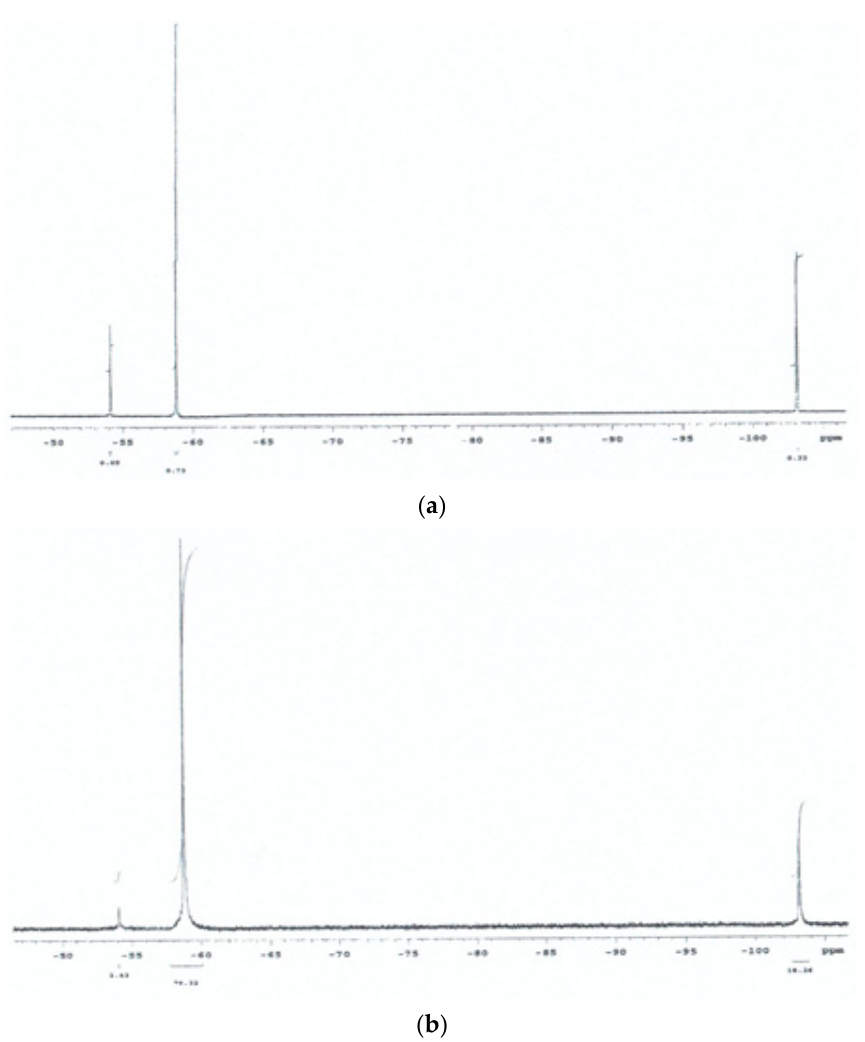
Figure 2. 19 F-NMR spectra of ( a ) polymer ( 13 ) and ( b ) polymer ( 16 ) measured for solutions in dichloromethane at 25 °C. Chemical shifts ( δ ppm) of the fluoro residues are given relative to hexafluorobenzene, which is taken as 0 ppm. Note that all the shift values, as elsewhere, are negative. Table 2. Conditions and results for various capping experiments with polymers ( 13 ) and ( 14 ).